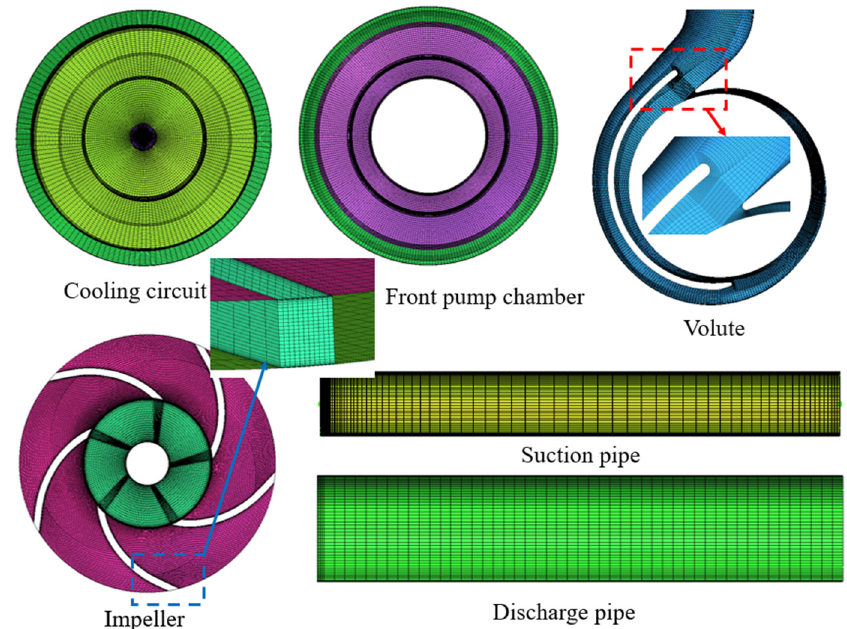
Figure 5. Mesh scheme of the gap in the cooling circuit.